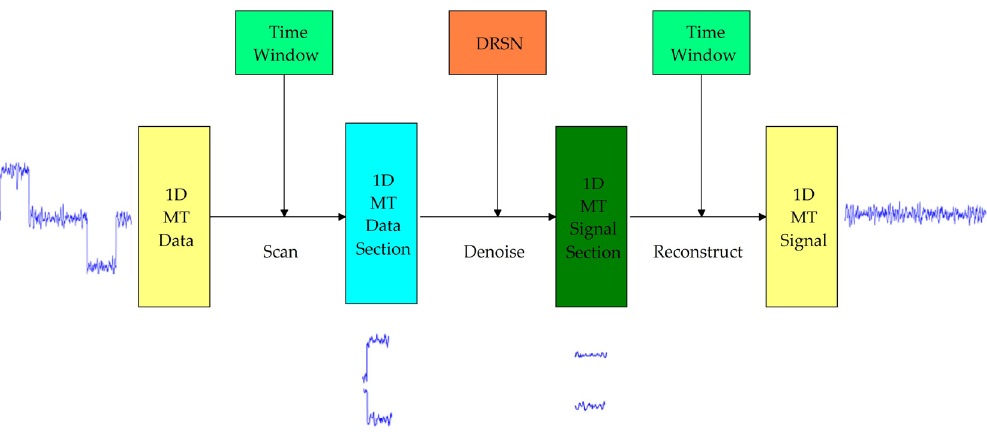
Figure 8. Flowchart of the proposed denoising process method. The blue line on the far left represents the noisy analog signal. The following the noise signal is equally divided by the time window. And then the signal after DRSN processing. Finally, the processed signals are spliced according to the time window.